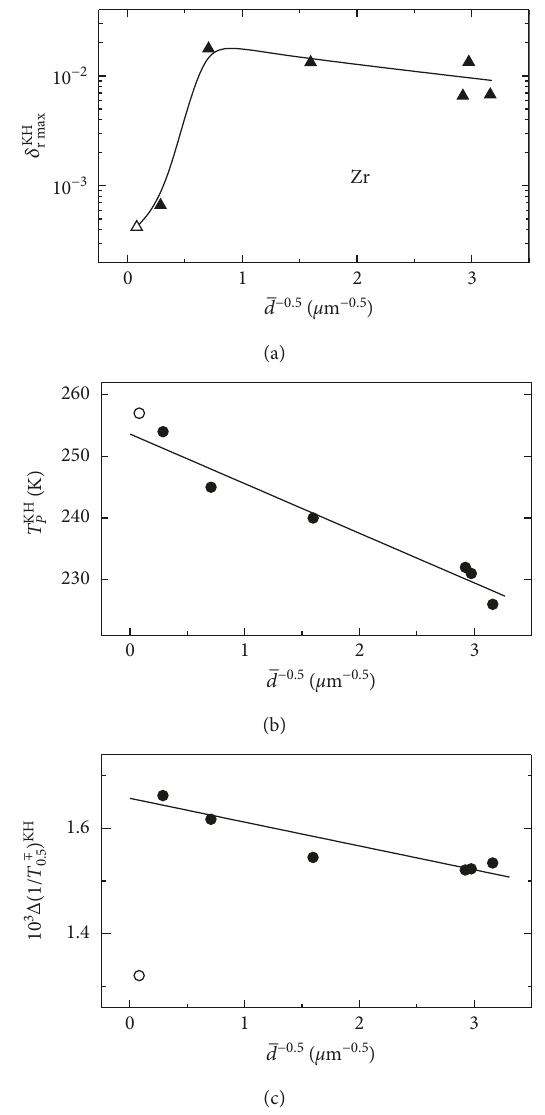
Figure 2: Dependences of (a) the peak height δ temperature T P , and (c) the peak width mean grain size d . Full symbols are the data of this work; empty symbols are taken from